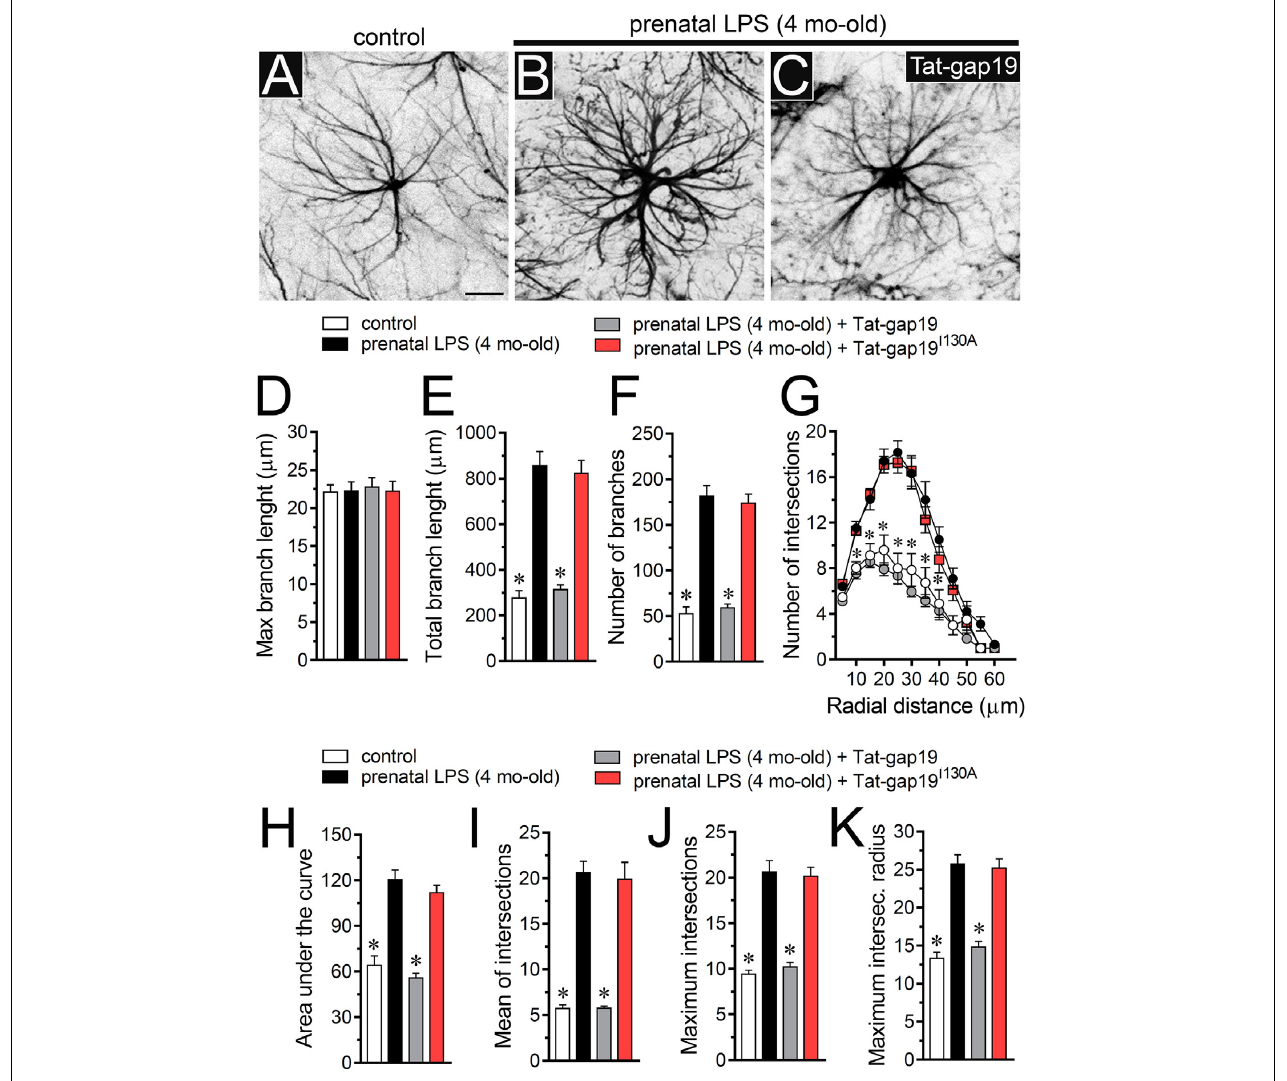
FIGURE 5 | Prenatal LPS exposure increases the arborization of hippocampal astrocytes in the offspring by a mechanism involving the activation of Cx43 hemichannels. (A–C) Representative GFAP (black) positive hippocampal astrocytes from control offspring (A) or prenatally LPS-exposed offspring of 4 months old alone (B) or plus the in vivo administration of 23 mg/kg Tat-gap19 (C) . (D–F) Averaged data of maximum branch length (D) , total branch length (E) and number of branches (F) by hippocampal astrocytes in acute slices from control offspring (white bars) or prenatally LPS-exposed offspring (black bars) of 4 months old. Also shown are the effects of in vivo administration of 23 mg/kg Tat-gap19 (gray bars) or its inactive form: 23 mg/kg Tat-gap19 I130A (red bars). ∗ p < 0.0001 versus LPS, one-way ANOVA Dunnett’s post hoc test, mean ± S.E.M., n = 3. (G) Averaged data of Sholl analysis by hippocampal astrocytes from control offspring (white circles) or prenatally LPS-exposed offspring of 4 months old alone (black circles) or plus the in vivo administration of 23 mg/kg Tat-gap19 (gray circles) or 23 mg/kg Tat-gap19 I130A (red circles). ∗ p < 0.001 versus LPS, two-way ANOVA Tukey’s post hoc test, mean ± S.E.M., n = 3. (H–K) Averaged data of area under the curve of Sholl analysis (H) , maximum intersection (I) , maximum intersection radius (J) , and mean of intersections (K) by hippocampal astrocytes from control offspring (white bars) or prenatally LPS-exposed offspring of 4 months old alone (black bars) or plus the in vivo administration of 23 mg/kg Tat-gap19 (gray bars) or 23 mg/kg Tat-gap19 I130A (red bars). ∗ p < 0.0001 versus LPS, one-way ANOVA Dunnett’s post hoc test, mean ± S.E.M., n = 3. Calibration bar = 40 µ